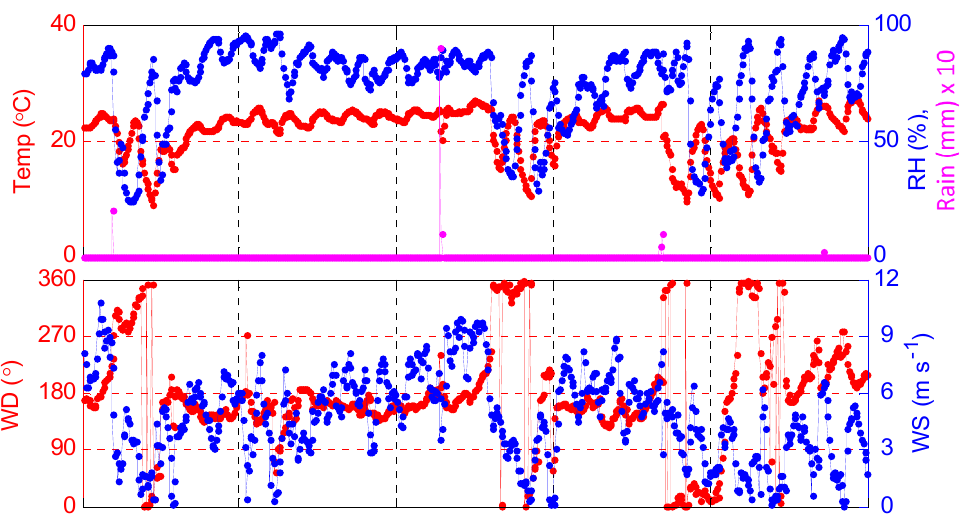
Figure 3. Measurements of meteorological parameters, trace chemical pollutants, and mercury species during the Grand Bay Intensive in spring